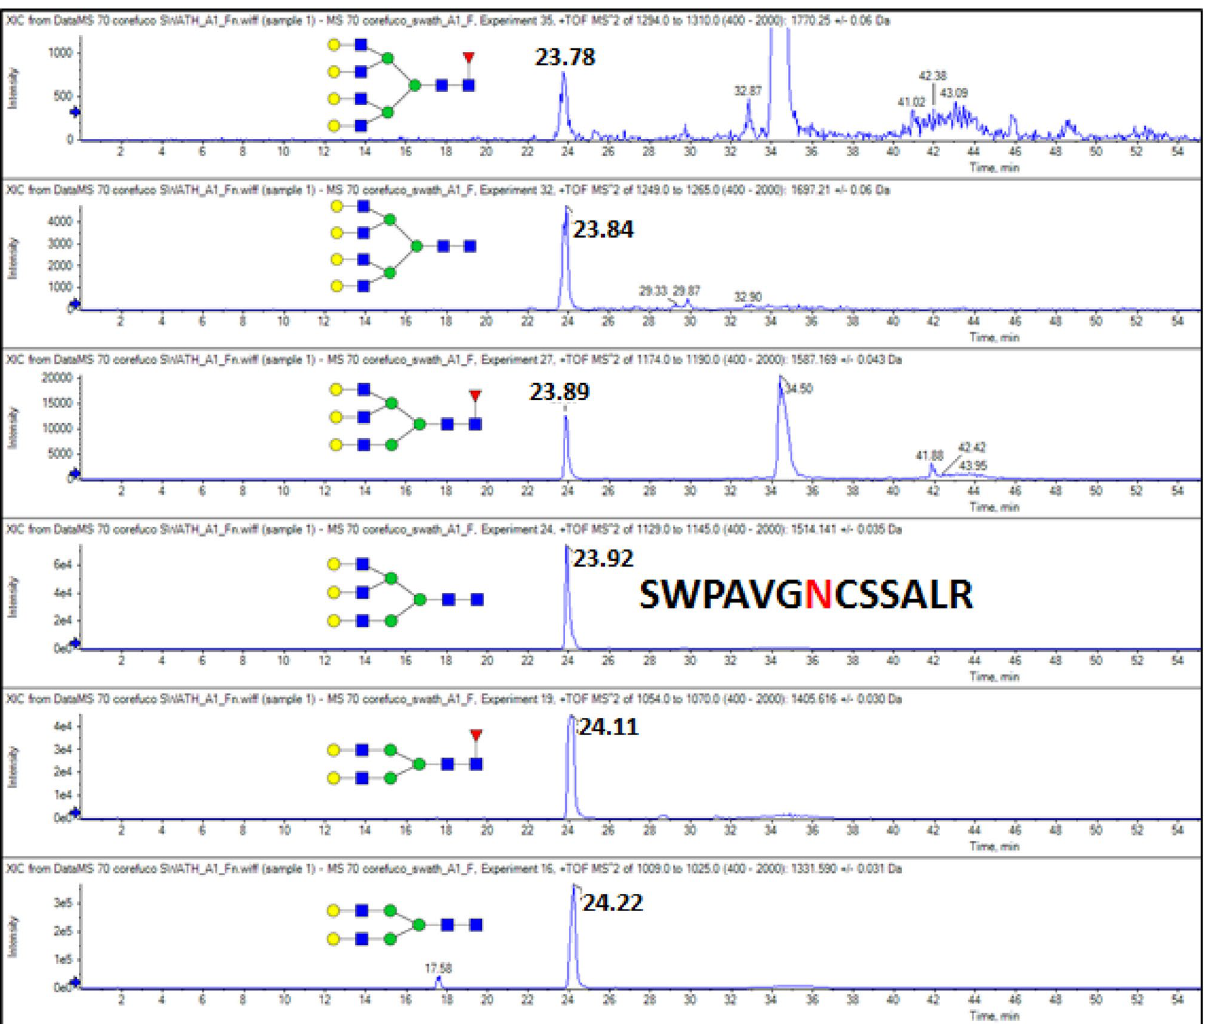
Figure 3. XIC chromatogram of six glycoforms of the SWPAVGNCSSALR glycopeptide of hemopexin extracted from the GP-SWATH DIA data of a MARS14 depleted serum sample treated with α2-3,6,8,9 neuraminidase, α1-2 and α1-3,4